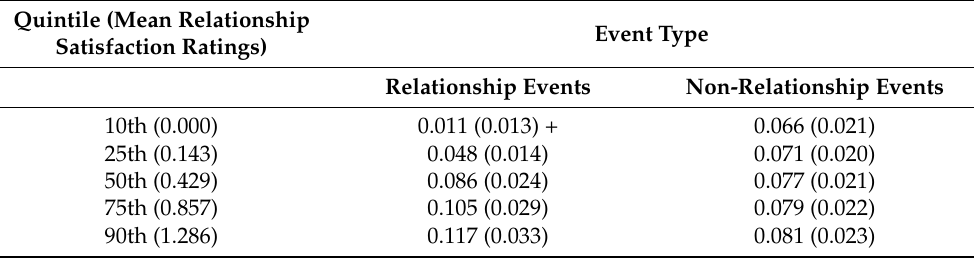
Table 6. Conditional Indirect Effects of Fading Affect Bias (FAB) for Relationship and Non- Relationship Events across Quintiles of Self-Reported Relationship Satisfaction Ratings through Event Rehearsal Frequency